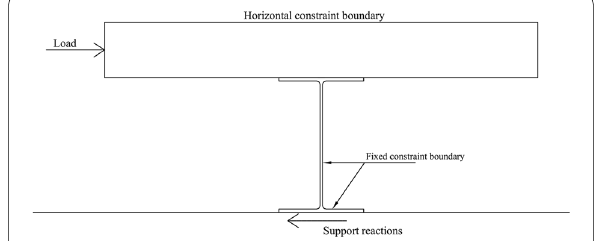
Fig. 15 Sketch of transverse push-out test